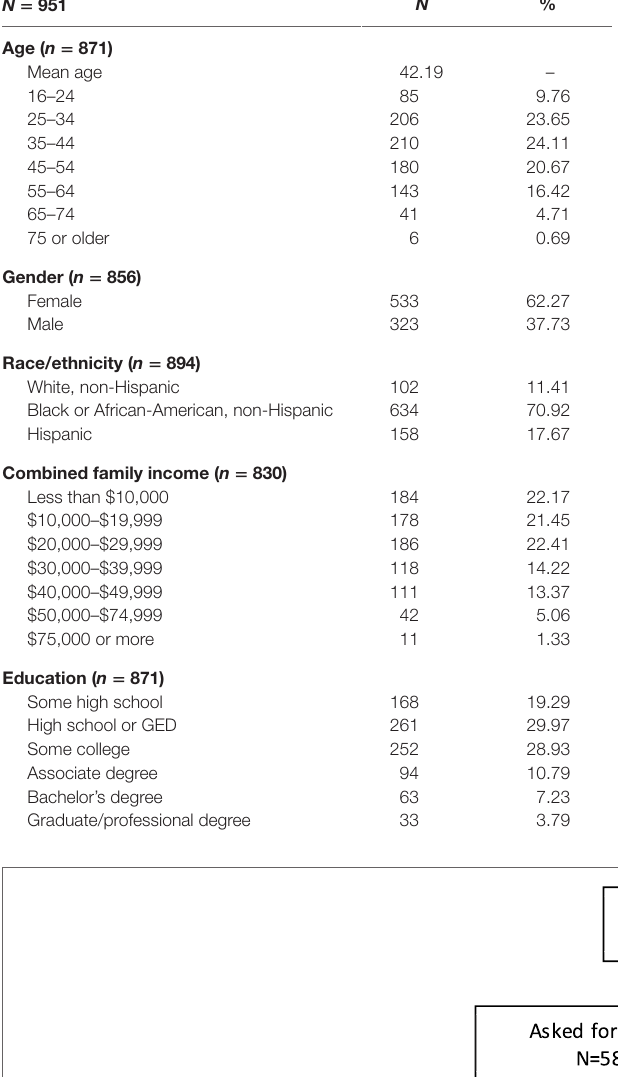
Table 1 | survey participant